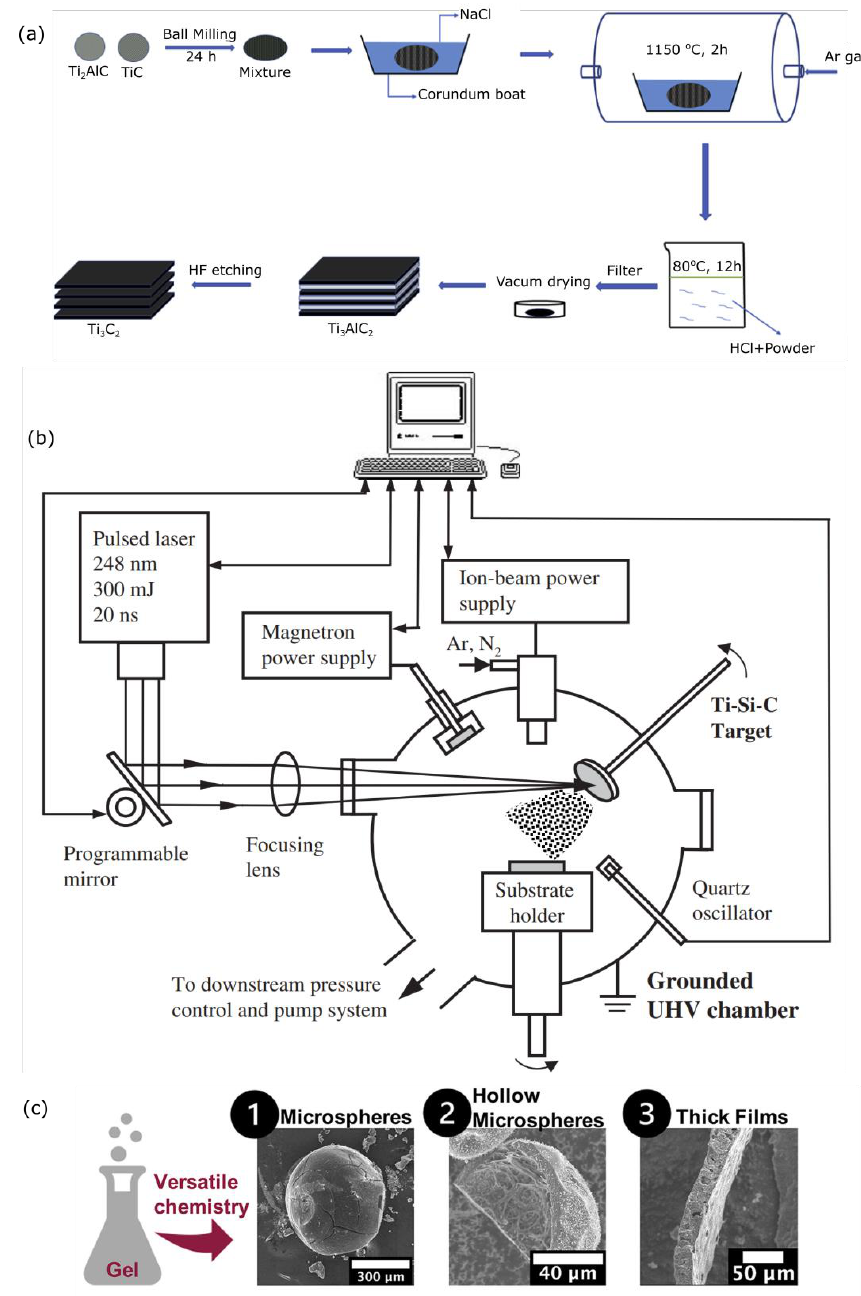
Figure 4. Low-temperature MAX synthesis; ( a ) molten salt method with lower synthesis temperature of MAX-phase Ti 3 AlC 2 by 200 °C [55], ( b ) experiment setup of the magnetron sputtering assisted pulsed laser deposition (PLD) system [67], and ( c ) the result from MAX phases synthesized by using biopolymer sol-gel synthesis [74].